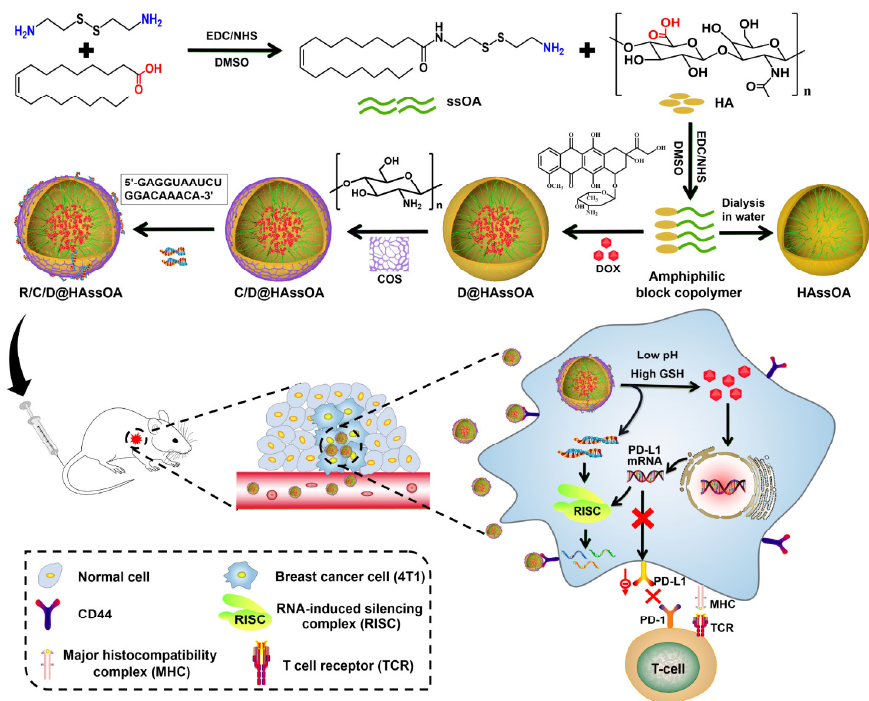
Figure 2. Schematic illustration of pH/redox dual-sensitive R/C/D@HAssOA synthesis and con- trolled release. Reprinted with permission from ref. [108]. Copyright© 2022 Elsevier B.V.